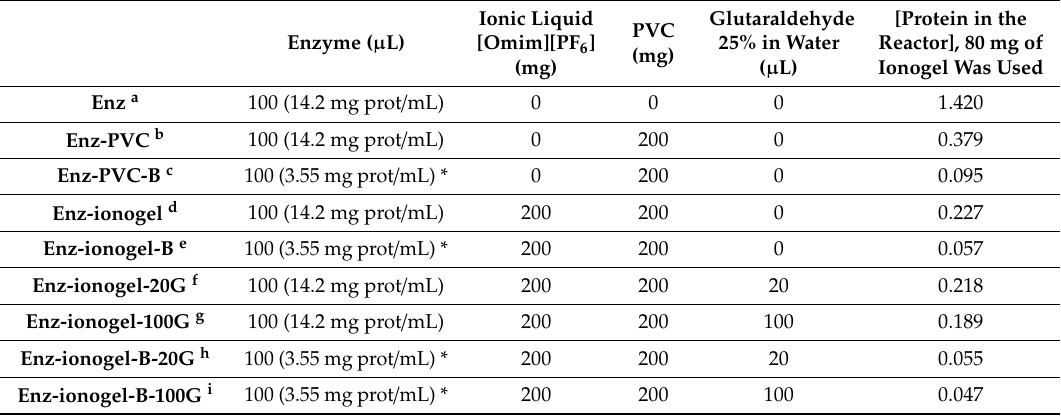
Figure 1. ( A ) Ionogel enzymatic derivative after casting, ( B ) Enzymatic derivative after crushing. Table 1. Chemical composition of the prepared ionogel enzymatic derivatives. The “ionogel” in the name of the immobilized enzyme stands for PVC + IL.